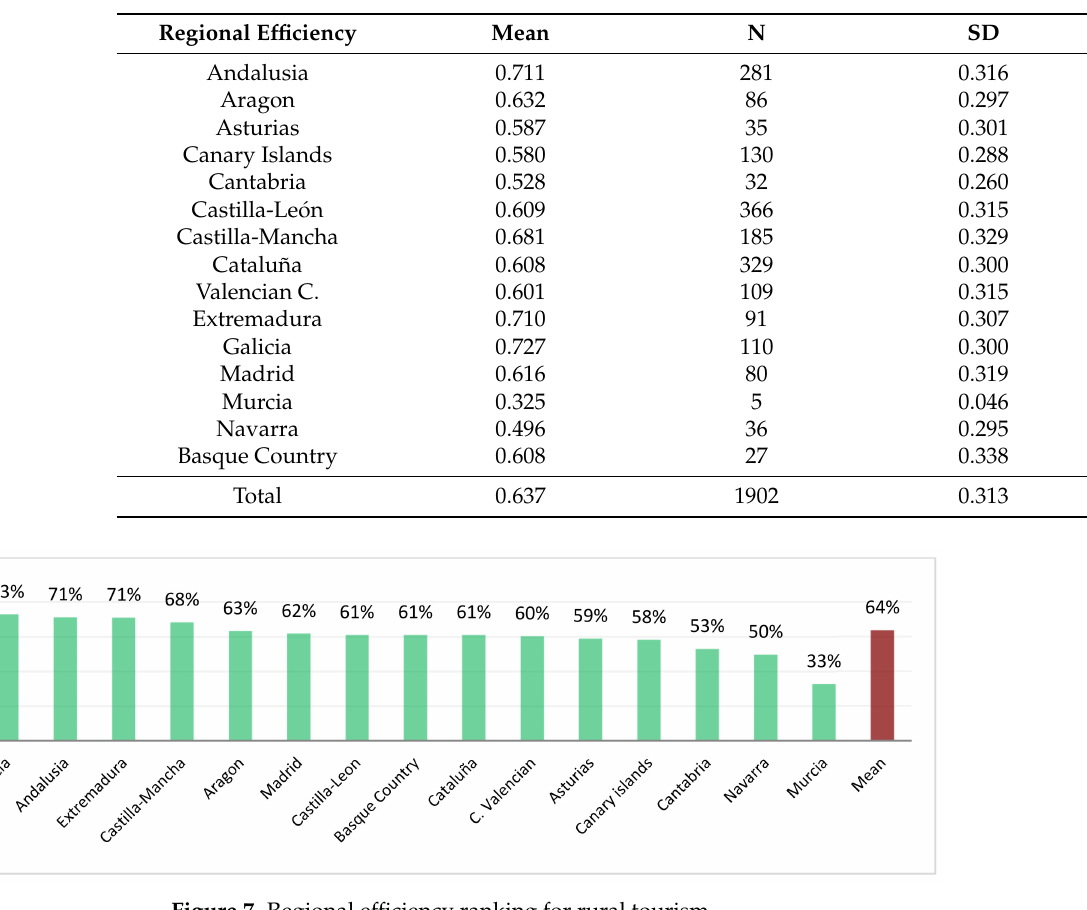
Table 8. Regional efficiency results in rural tourism destinations.